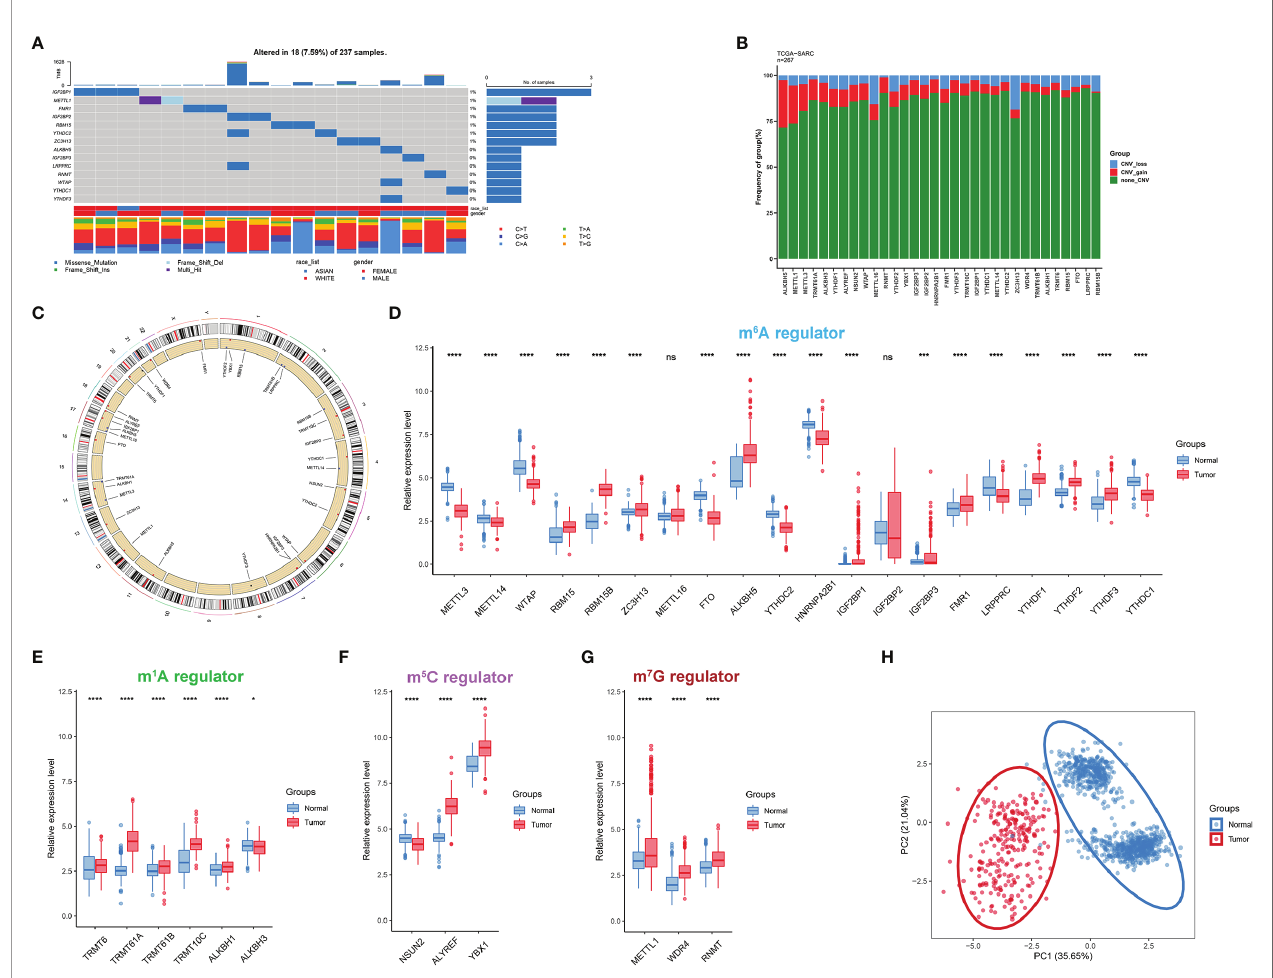
FIGURE 2 | Transcriptional and genetic alterations of RNA modi fi cation regulators in STS. (A) The mutation frequency of RNA modi fi cation regulators in 237 STS patients. The upper bar re fl ects the TMB. Every single column represents a patient. (B) The CNV alteration of RNA modi fi cation regulators in STS. The height of the column with a speci fi c color represents the CNV frequency (%). The color represents the CNV status including gain (red) and loss (blue). (C) The location of RNA modi fi cation regulators on human chromosomes. (D – G) The expression level of 32 RNA modi fi cation regulators between STS samples (red) and normal tissues (blue) in the TCGA-SARC cohort. The box plot extends from the 25th to 75th percentile and the central line indicates the median. (H) Principal component analysis (PCA) of 32 RNA modi fi cation regulators for discriminating between tumor and normal samples. ns, p ≥ 0.05; *, 0.01 ≤ p < 0.05; **, 0.001 ≤ p < 0.01; ***, 0.0001 ≤ p < 0.001; ****, p <